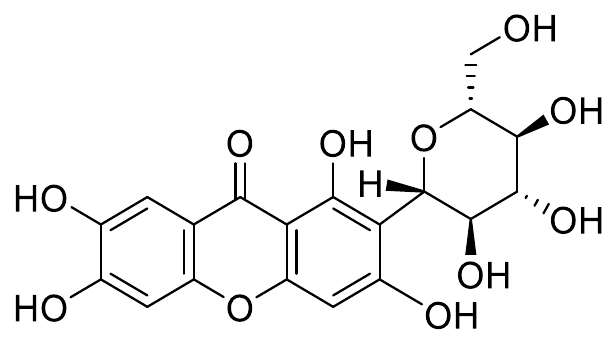
Figure 2. The chemical structure of mangiferin.